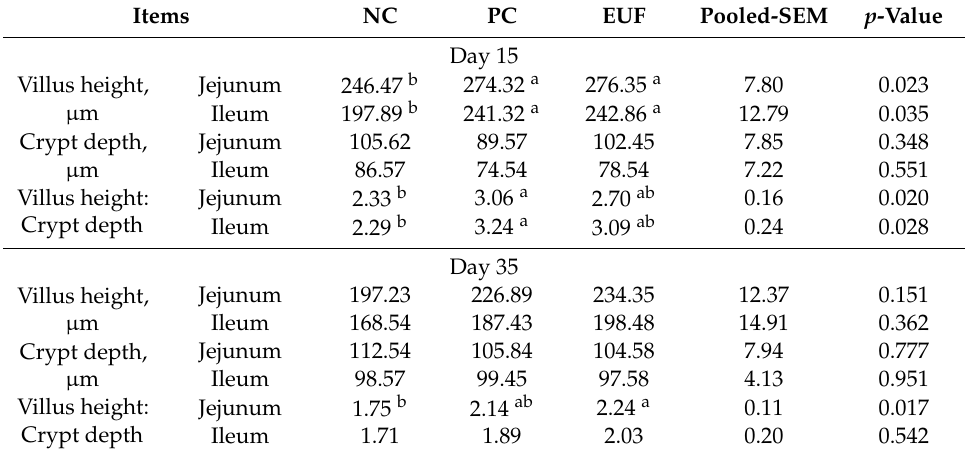
Table 4. Jejunal and ileal morphology in piglets 1,2